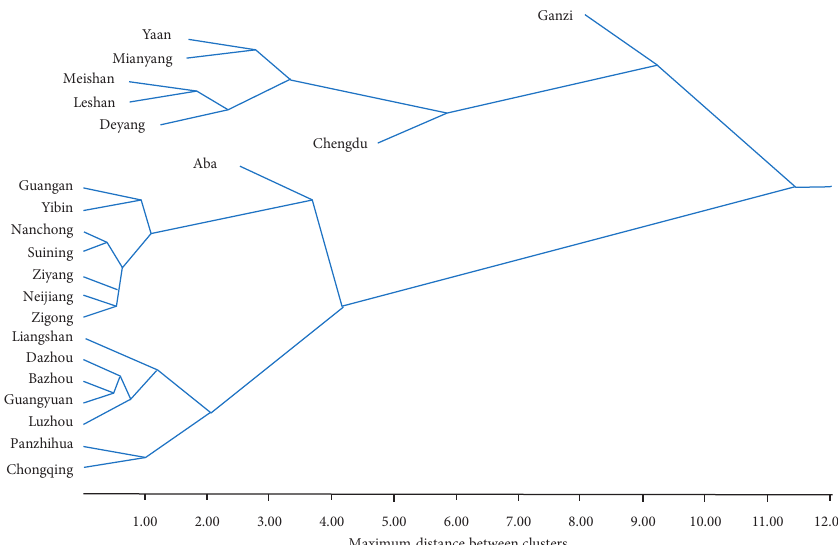
Figure 8: City clusters of urban thermal environment contributions of the